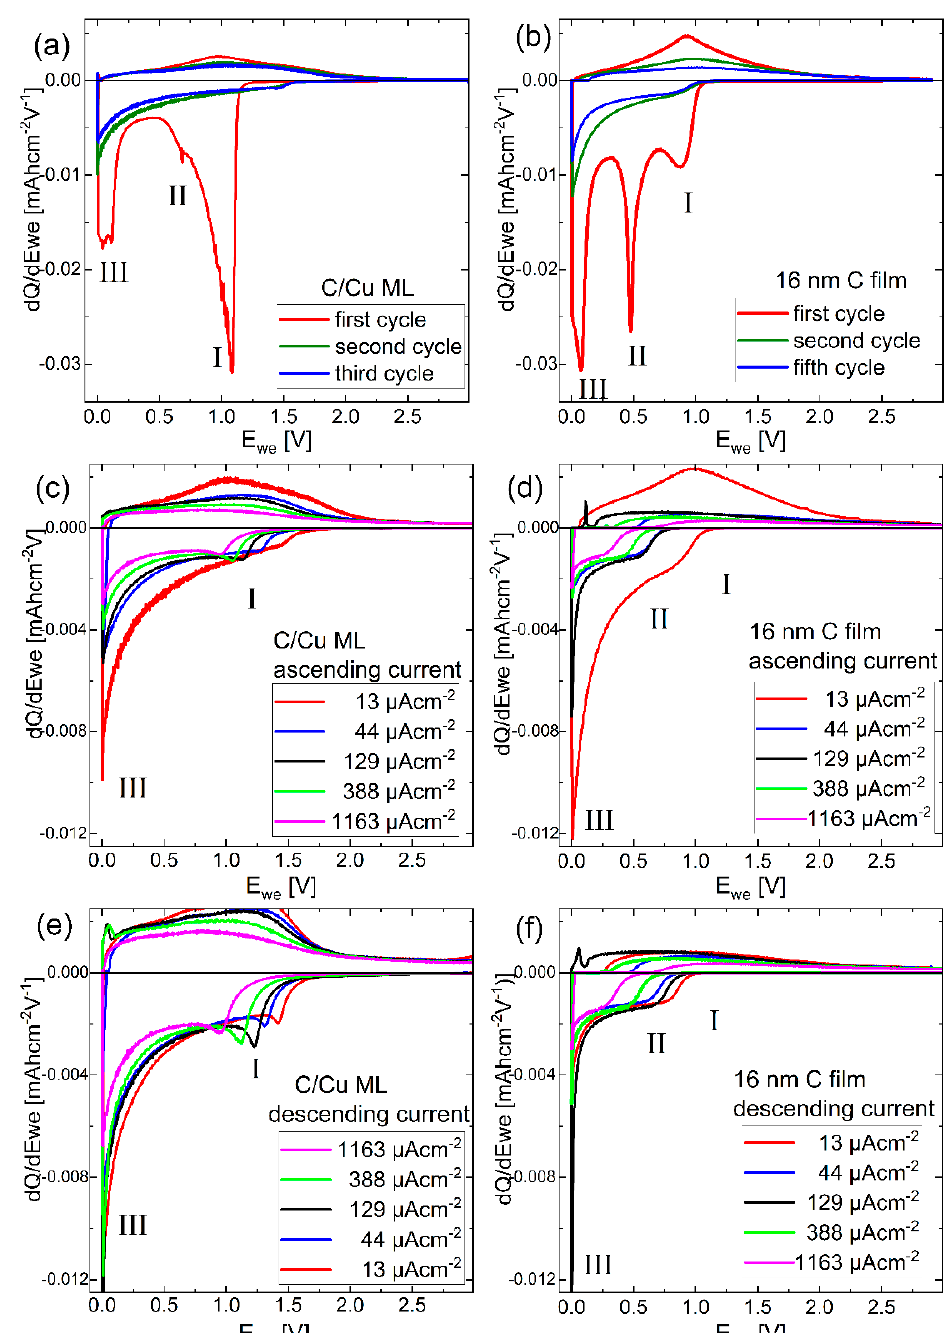
Figure 7. Differential charge plots (dQ/dV curves) of ( a , b ) the 1st, 2nd, and 5th CC cycle with 13 µAhcm − 2 , ( c , d ) the 2nd, 7th, 12th, 17th, and 22nd cycle for the ascending current, ( e , f ) 22nd, 28th, 33rd, 38th and 43rd cycle for the descending current for the ( a , c , e ) C/Cu ML and ( b , d , f ) carbon single-film. A color version of this figure can be viewed online.